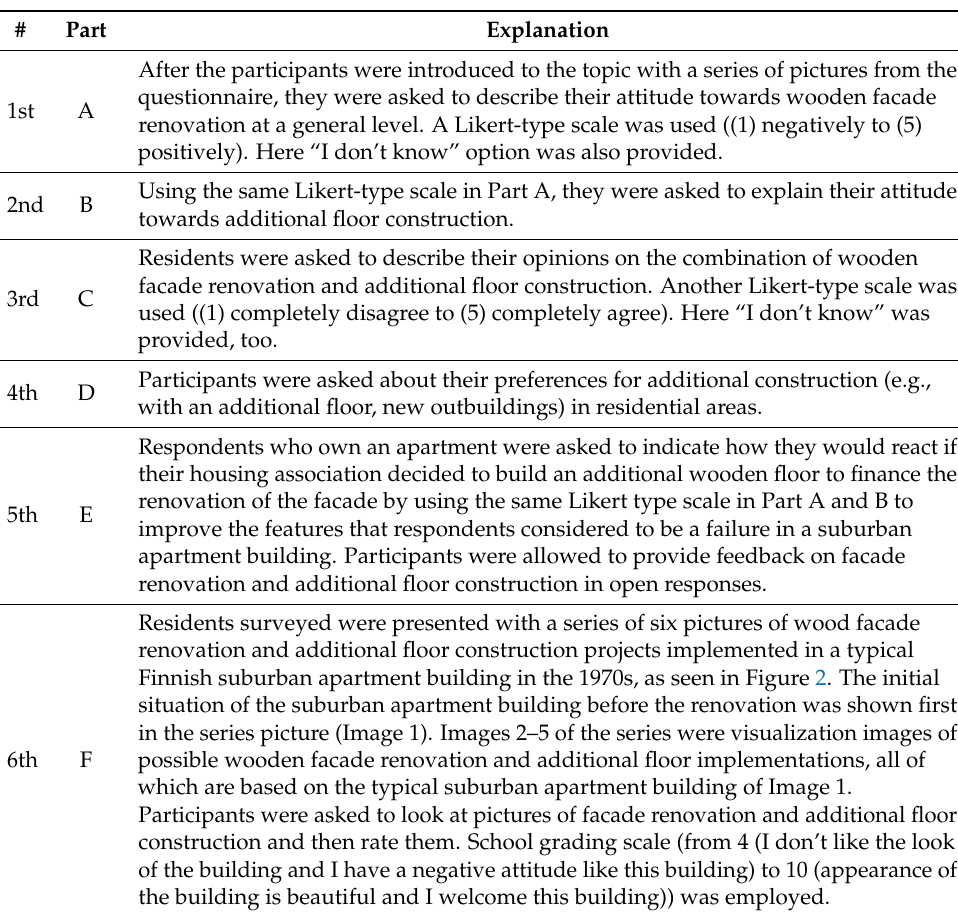
Table 1. The questionnaire used in this study.